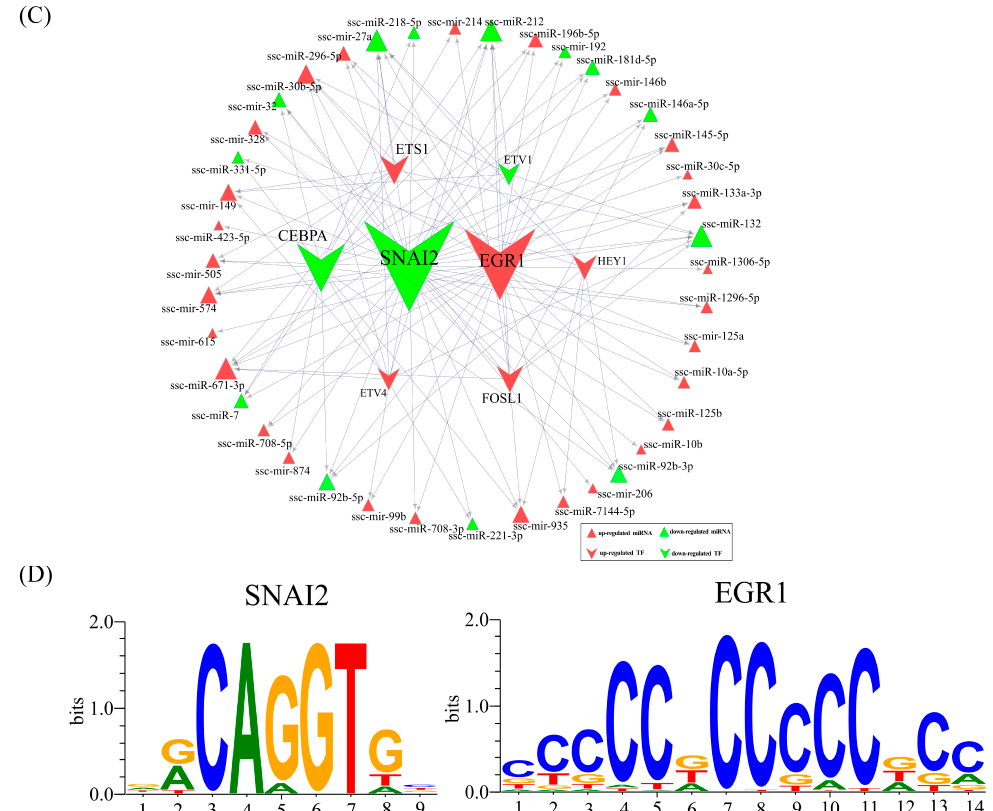
Figure 4. Analyses of TF-mRNA and TF-miRNA networks in P-N1ICD vs. P-Control. ( A ) The network of TF-mRNA in P-N1ICD vs. P-Control; red circular represents upregulated DEGs; green circular represents downregulated DEMs; red V-shape represents upregulated TFs; and green V-shape represents downregulated TFs. ( B ) The sequence logo display for transcription factors of SNAI2 and EGR1 whose binding sites are significantly enriched in the regulation of DEGs in P-N1ICD vs. P-Control. ( C ) The network of TF-miRNA in P-N1ICD vs. P-Control; red triangle represents upregulated DEMs; green triangle represents downregulated DEMs; red V-shape represents upregulated TFs; and green V-shape represents downregulated TFs. ( D ) The sequence logo display for transcription factors of snail family transcriptional repressor 2 (SNAI2) and early growth response 1 (EGR1) whose binding sites are significantly enriched in the regulation of DEMs in P-N1ICD vs. P-Control.